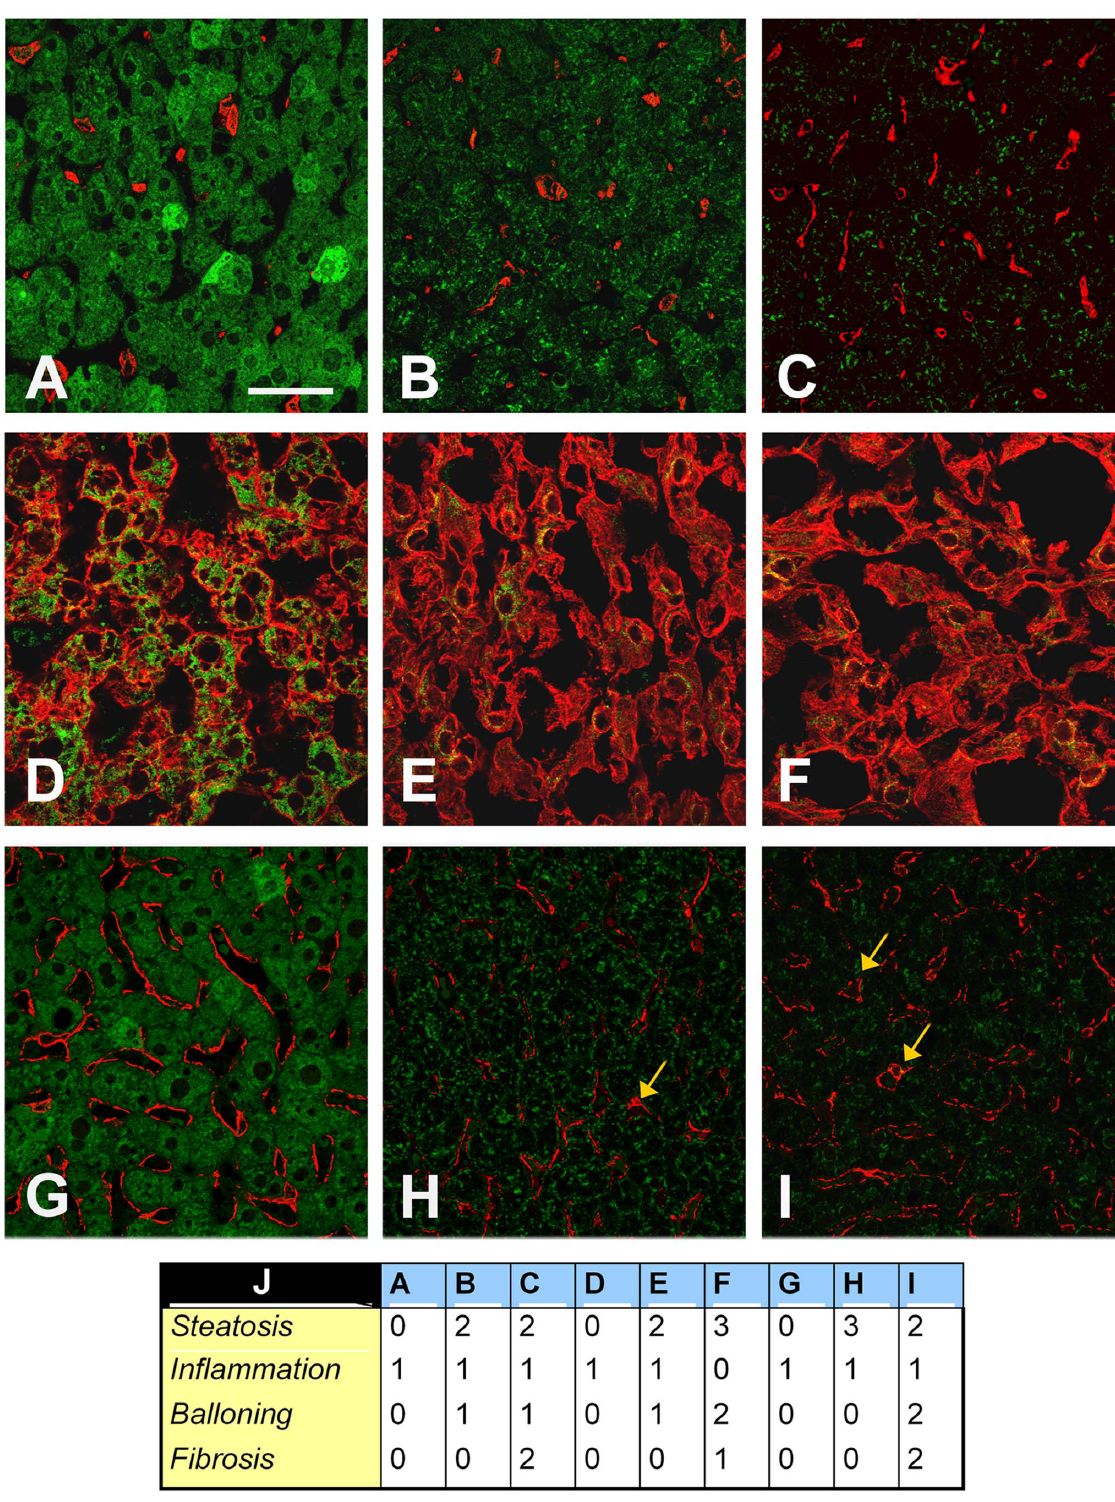
Figure 5 . Representative confocal immunofluorescence of Klotho co-receptor localization in liver tissues. The representative confocal immunofluorescence was performed on liver tissue cryostat sections OCT-embedded. ( A–C ) Co-staining of Klotho co-receptor (green) and CD163 (red) in children without NAFLD ( A ), with NAFLD NASH 2 ( B ) and with NASH + ( C ). ( D–F ) Co-staining of Klotho co-receptor (green) and cytokeratin 8/ 18 (red) in children without NAFLD ( D ), with NAFLD NASH 2 ( E ) and with NASH + ( F ). ( G–I ) Co-staining of Klotho co-receptor (green) and alpha-SMA (red) in children without NAFLD ( G ), with NAFLD NASH 2 ( H ) and with NASH + ( I ). Yellow arrows indicate hepatic stellate cells. The white bar represents a 30 m m length. ( J ) Histological scores for panels from A to I.